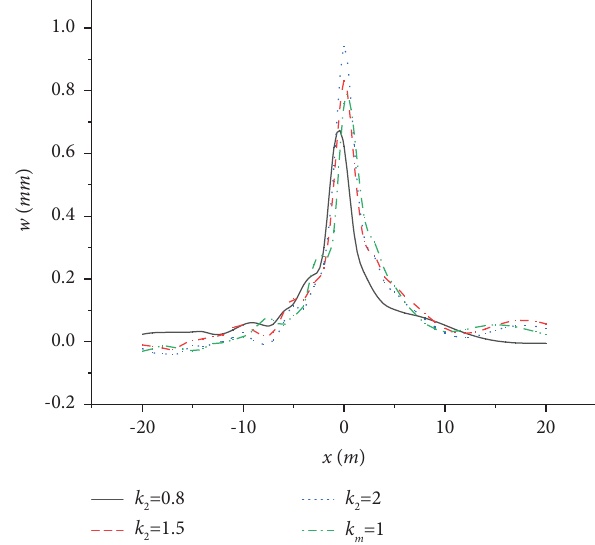
Figure 6: Plate deformation curves in x- direction due to E